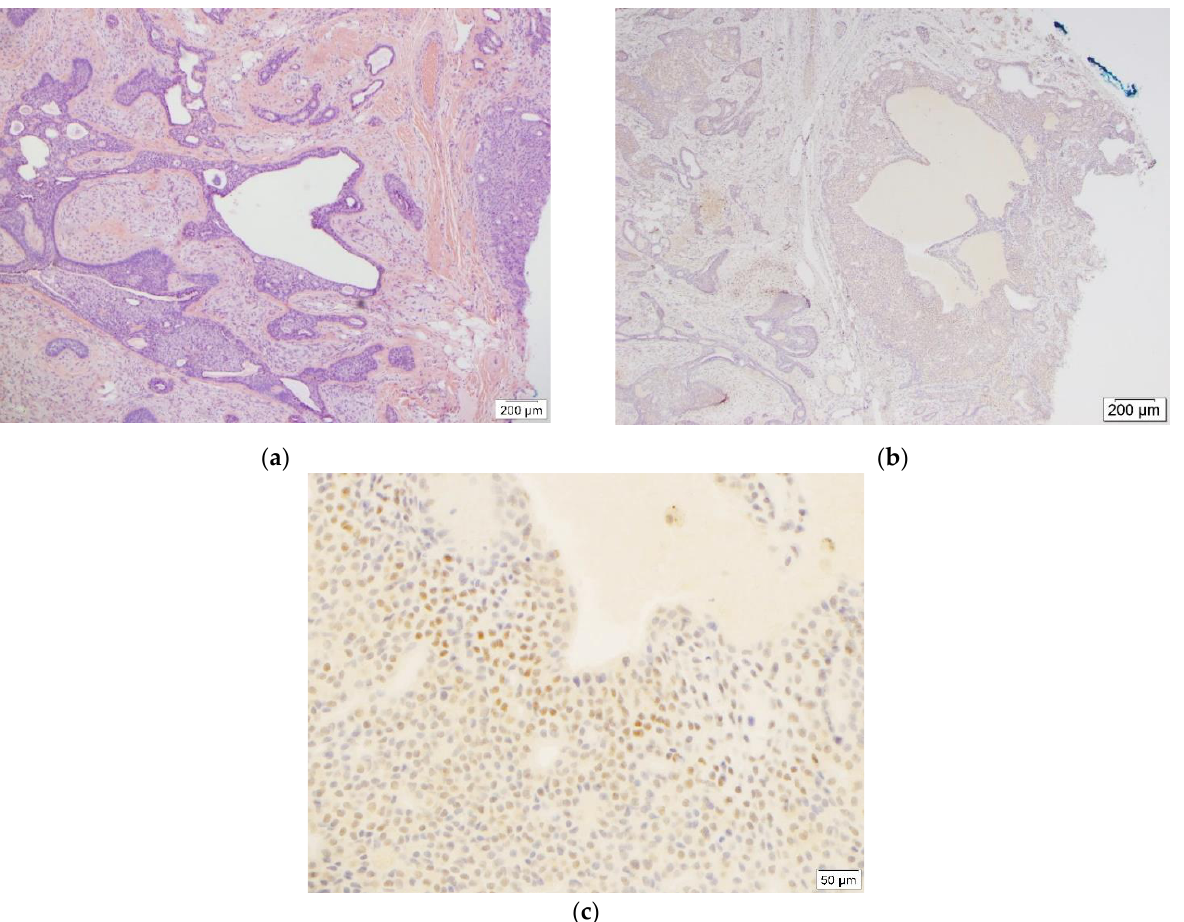
Figure 2. This figure demonstrates benign chondroid syringoma (( a), H&E, 4×, case #2) and weak (1+) as well as adjacent moderate (2+) TFE3 staining (( c ), TFE3, 20×) in less than 20% and 5% of tumor cells, respectively (( b ), TFE3, 4×).